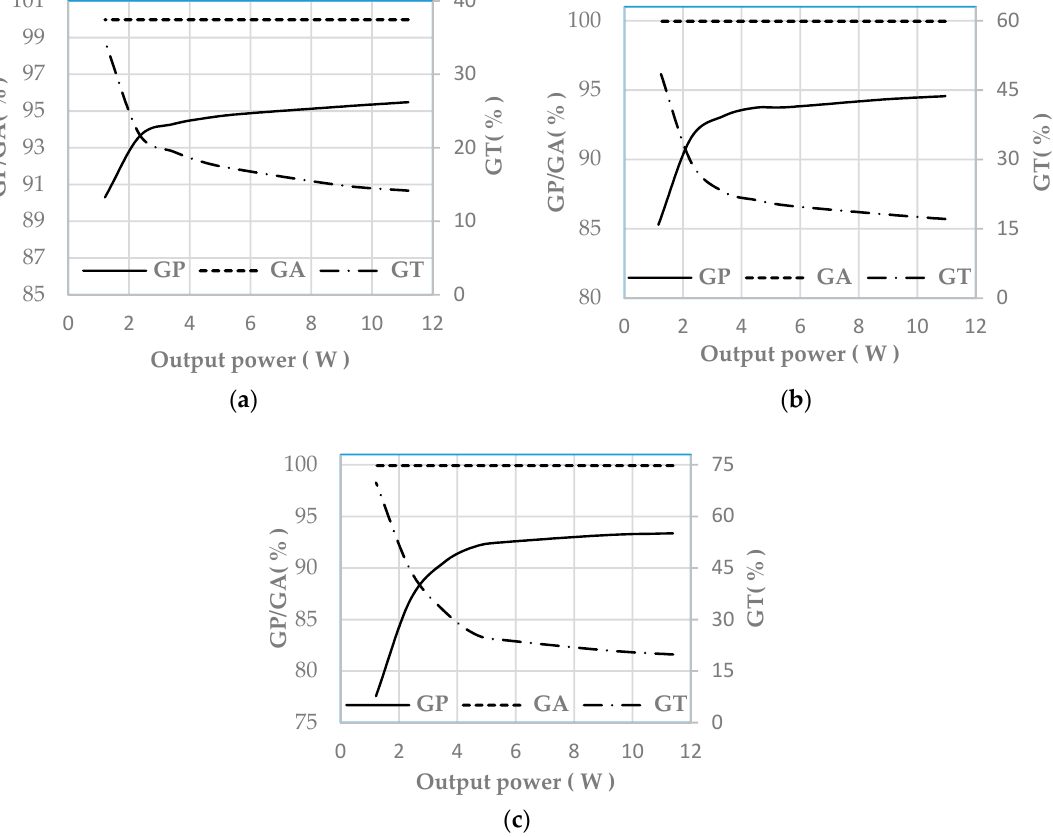
Figure 9. Power gain, transducer gain, and available gain of coupling compensation circuit controlled by proposed method: ( a ) vertical distance of coils is 1.2 cm ( k = 0.51); ( b ) vertical distance of coils is 1.5 cm ( k = 0.40); ( c ) vertical distance of coils is 1.8 cm ( k = 0.31).